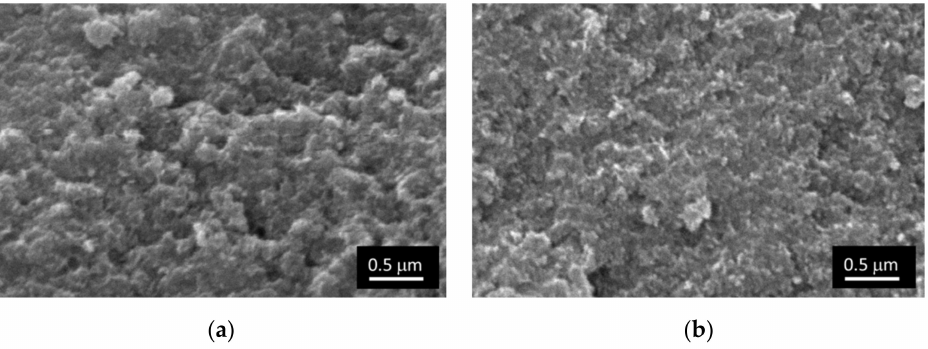
Figure 2. SEM images of NiAl-CO 3 with Ni/Al = 3 ( a ) and NiAlO x with Ni/Al = 3 ( b